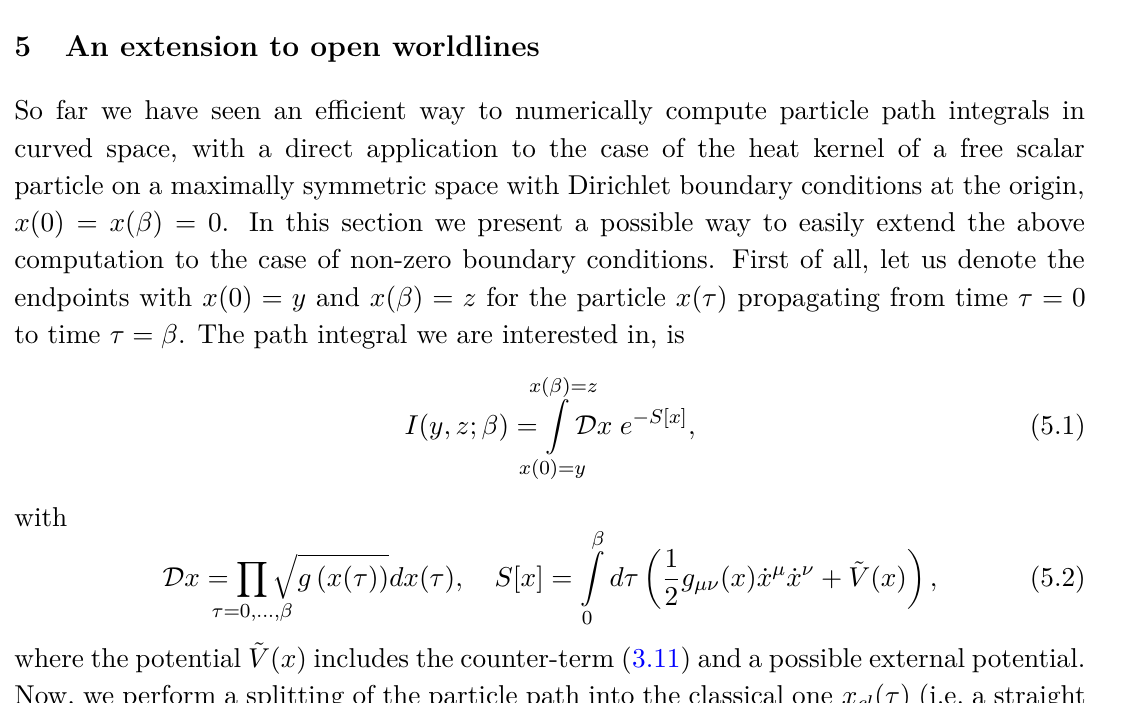
Figure 6 . Calculations of the heat kernel for the free scalar particle on a hyperboloid with D = 4 and | M | = 1